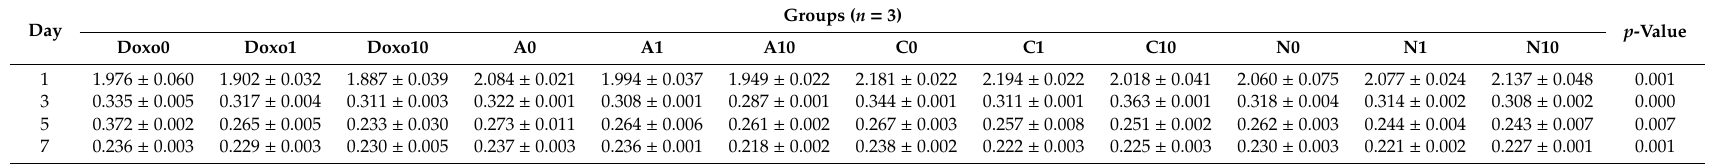
Table 1. The cellular viability of stem cell spheroids on Days 1, 3, 5, and